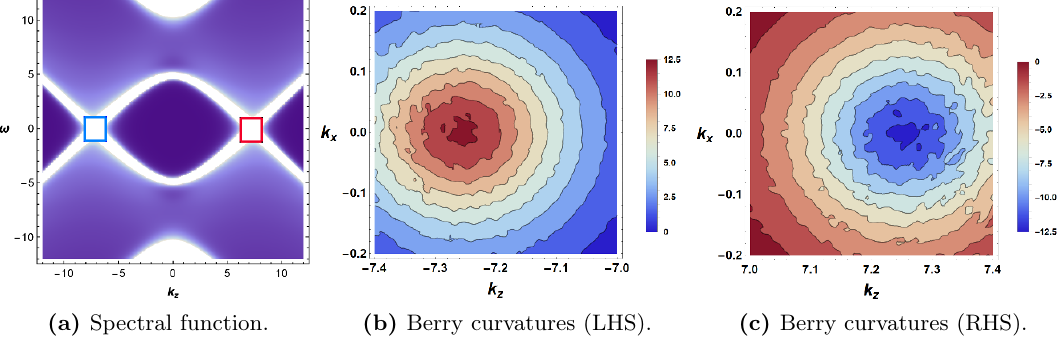
Figure 8. (a) Spectral function with scalar interaction. We used ( b; M ) = (8 ; 5 : 5) and T = 2 =(cid:25) . k x = k y = ! = 0. (b),(c): Berry curvatures near k z = (cid:0) 7 : 26 and 7 : 26 at the plane ( k y = (cid:0) 0 : 2, ! = 0), where topological numbers are still 1 and -1